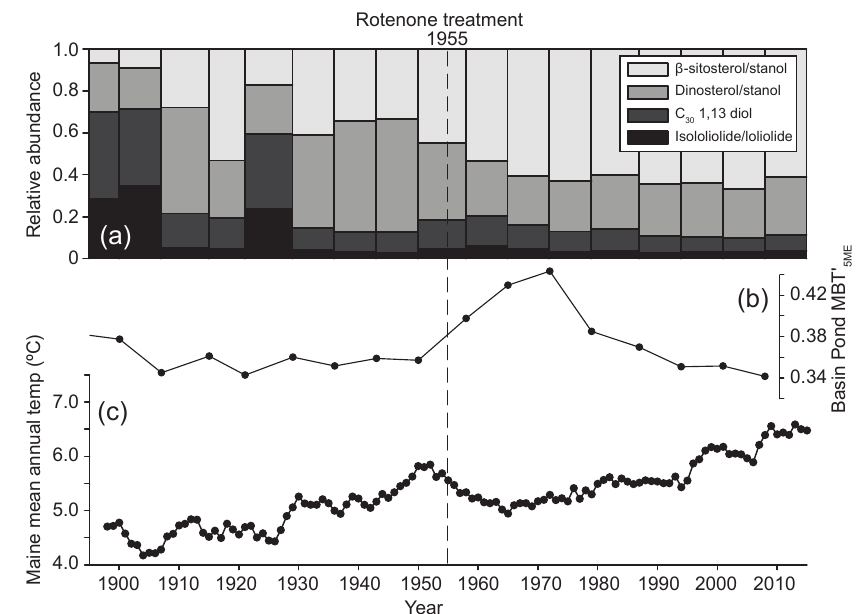
reconstruction, and algal lipid biomarkers in Basin 5ME record. (c) Maine statewide average temperature (NOAA, 2014). The 5ME